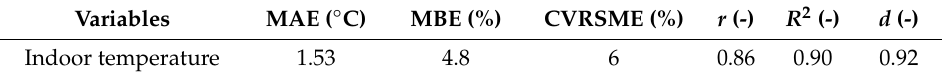
Table 3. Statistical indexes used to validate the building simulation model.